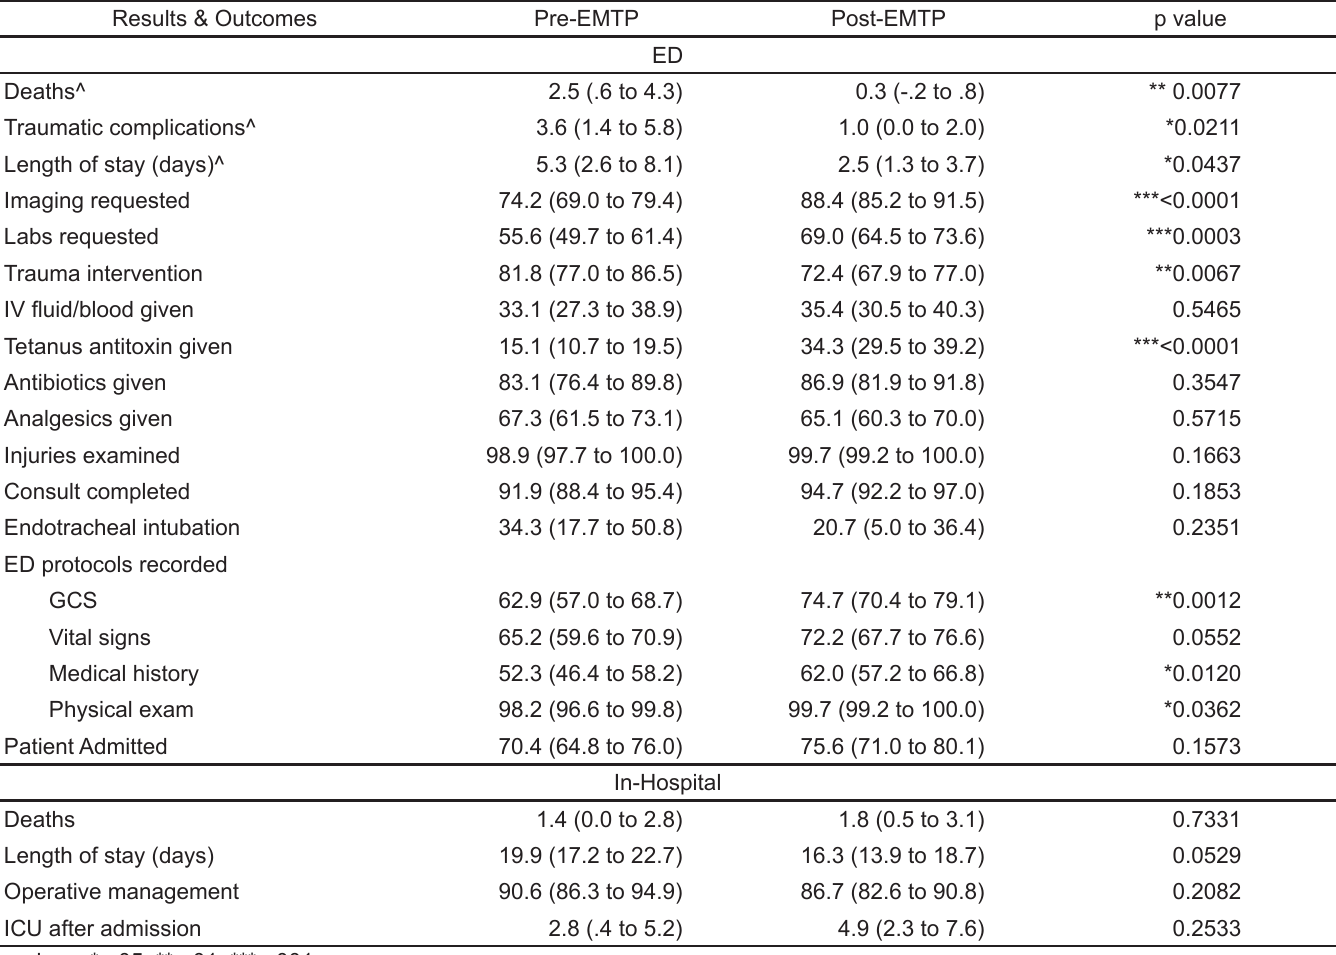
Table 4. Emergency medicine training program